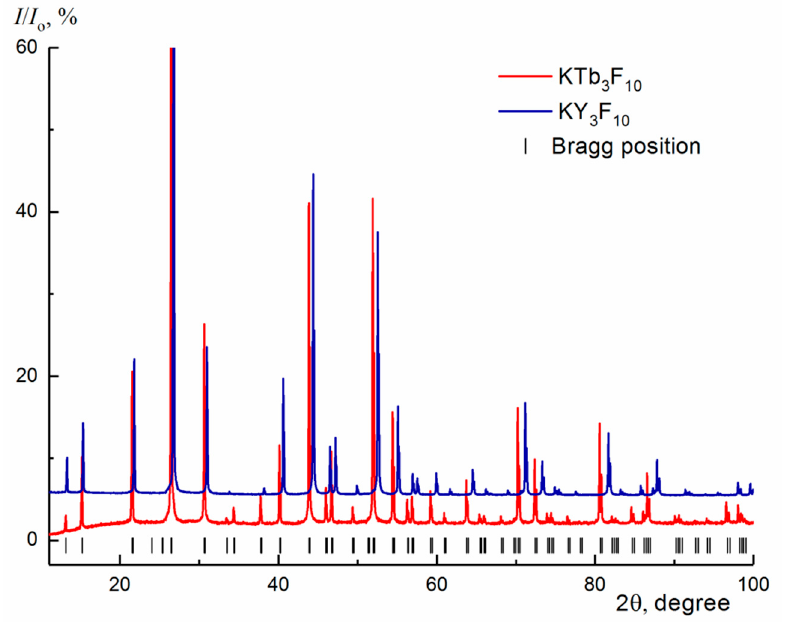
Figure 4. XRD patterns of the KYF and KTF crystals. The positions of Bragg reflection peaks for KTF (space group Fm 3 m ) are indicated.